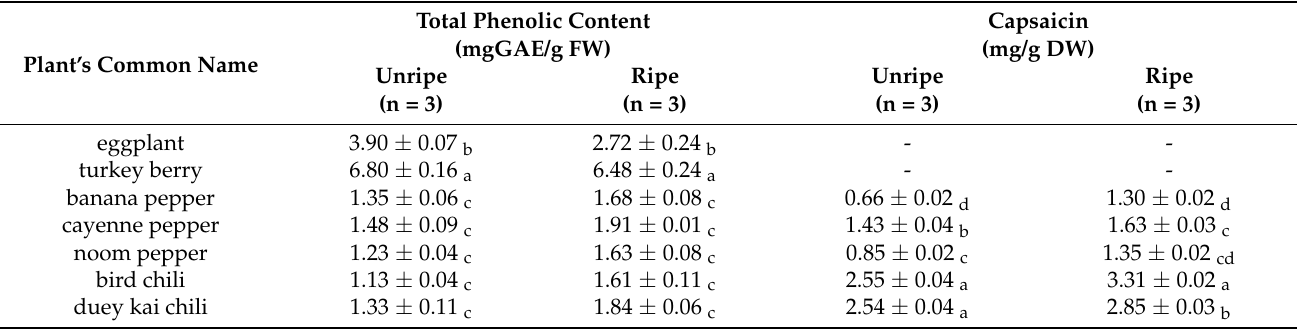
Table 5. Capsaicin and total phenolic contents found in seven solanaceous